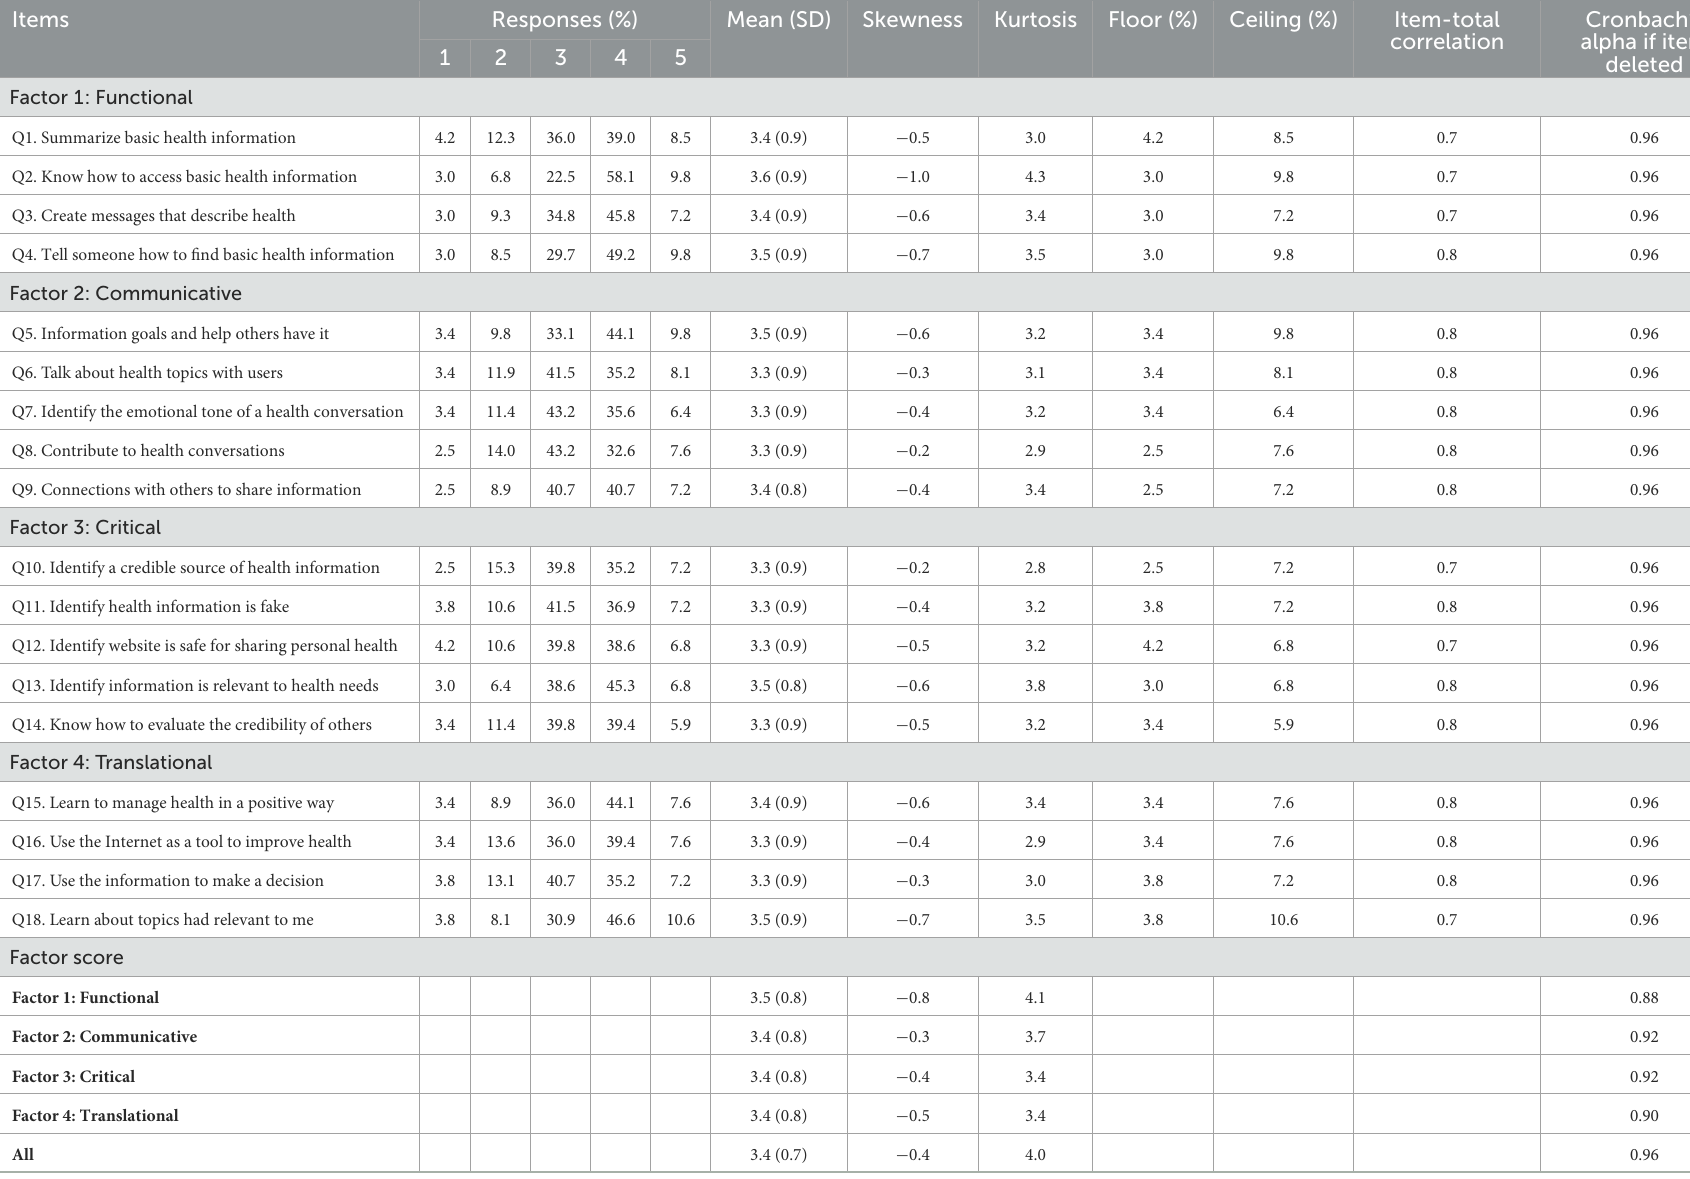
TABLE 3 Basic descriptions and reliability of transactional eHealth literacy. Items Responses (%) Mean (SD) Skewness Kurtosis Floor (%) Ceiling (%) Item-total